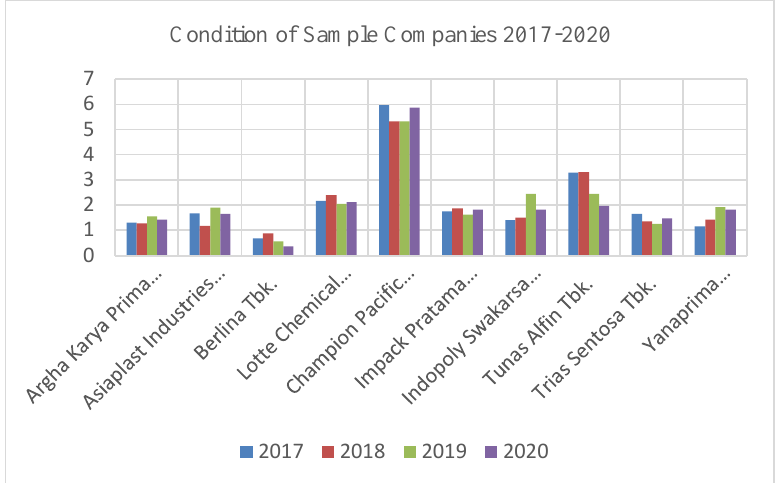
Figure 1: Discrimination Zone